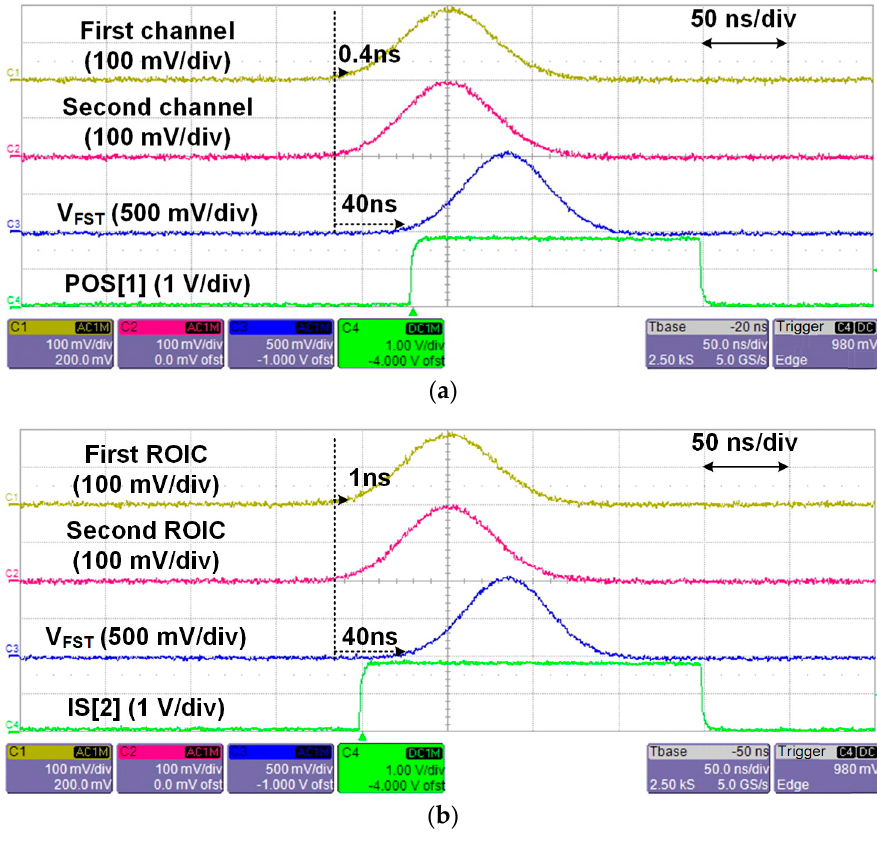
Figure 10. Measured input and output waveforms of the ( a ) ROIC and ( b ) ASP block.